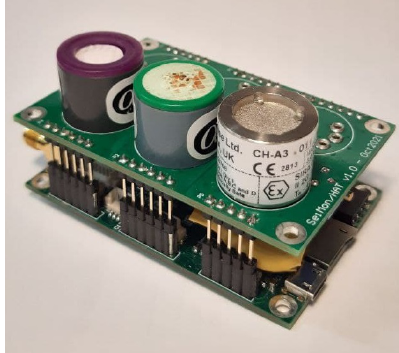
Figure 6. Sensor node device final